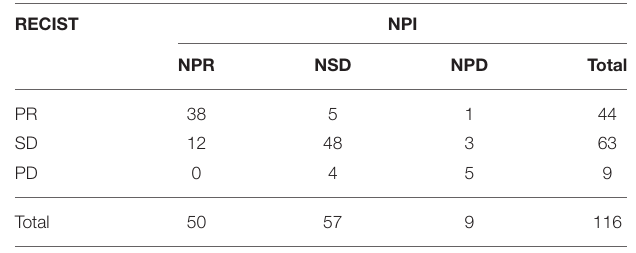
TABLE 3 | Comparison of treatment response assessments between RECIST and